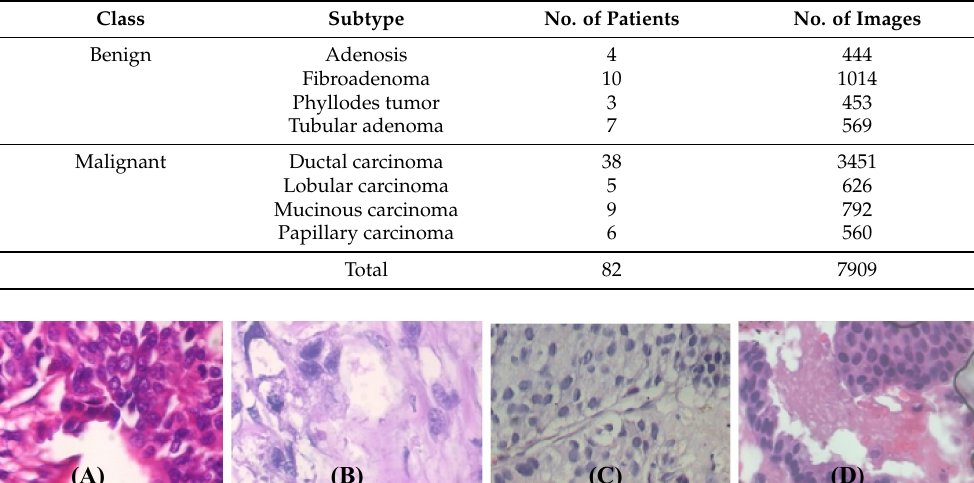
Table 2. The distribution of benign and malignant images over various subtypes.